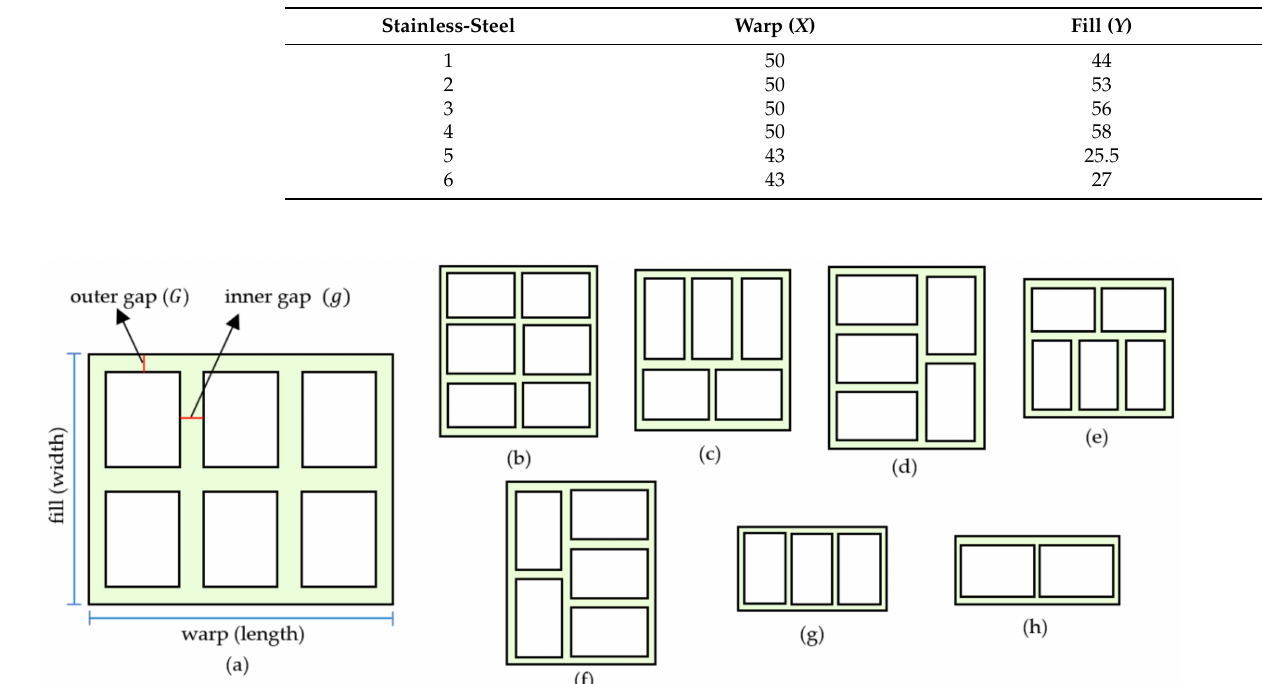
Figure 2. Illustration of the eight layouts ( a – h ) of the panel arrangement [10]. Table 5. Formulas for computing a ikl , which is the number of panels of type i ∈ { 1,2, . . . I } per